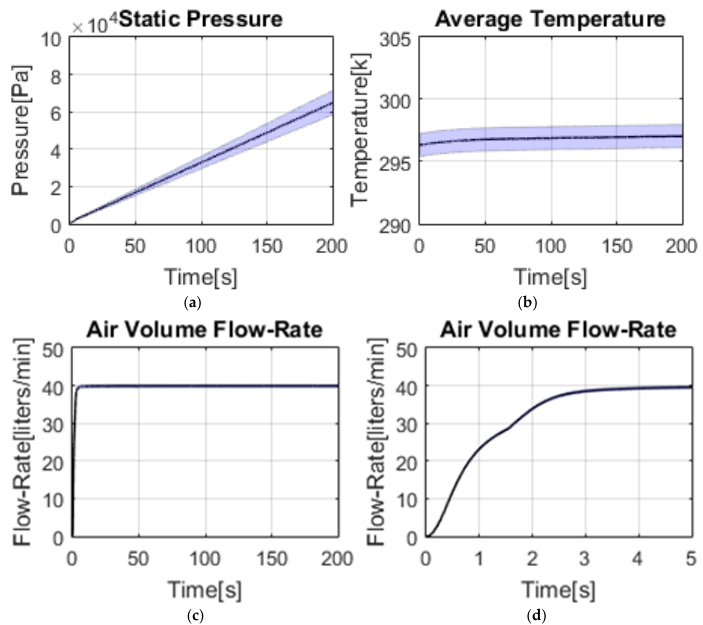
Figure 9. ( a ) Description of the pressure increase inside STARDUST-U during the air flow inlet at 40 L/min. ( b ) Description of the temperature variations measured during the experiment. ( c ) Description of the flow rate variation in the time. ( d ) Flow rate increase in the early stage from the accident experimental simulation. The results of pressure variations, flow rate variations and temperature variation obtained for vale D are comparable to those obtained for valve C. For the three different conditions (8 L/min, 27 L/min and 40 L/min) the first diagram shows the internal pressure trend of the chamber from the initial pressure of 200 Pa to atmospheric pressure. The blue line is the value detected by the measuring instruments (Edward or Pirani). The red line represents the minimum error value, while the green line is the maximum error value. The internal pressure has a linear trend and reaches the fixed boundary conditions in about 1200 s for flow rate of 8 L/min, 400 s for flow rate of 27 L/min and 250 for flow rate of 40 L/min. It is very interesting see how the slop of the pressure diagram increase with the increasing of the flow rate from 8 L/min to 27 L/min with a percentage of almost 100% and from 27 L/min to 40 L/min with a percentage of almost 60%. It means that it is not possible to go over the 1000 Pa/s as accident simulation with this facility because the maximum flow rate achievable is 100 L/min. (see Figure 10).